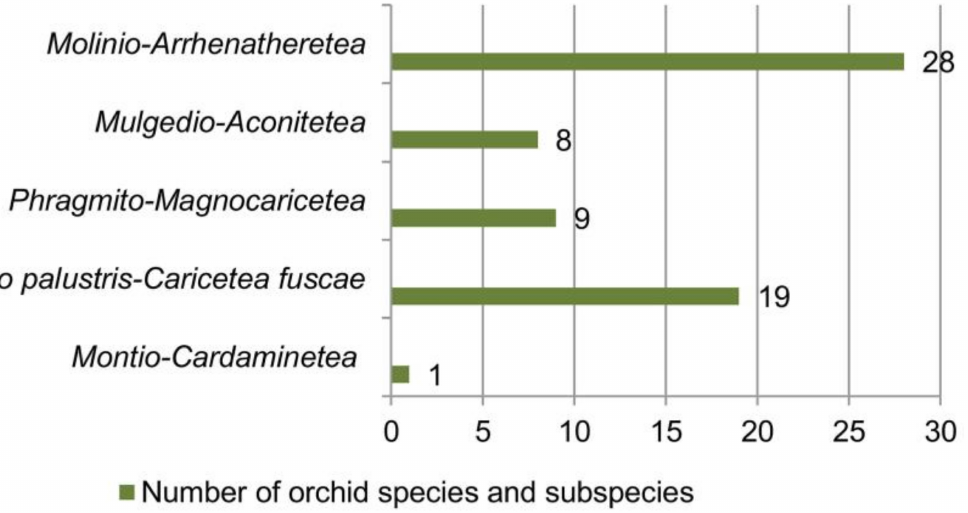
Figure 6. Richness of orchid species and subspecies in relation to vegetation